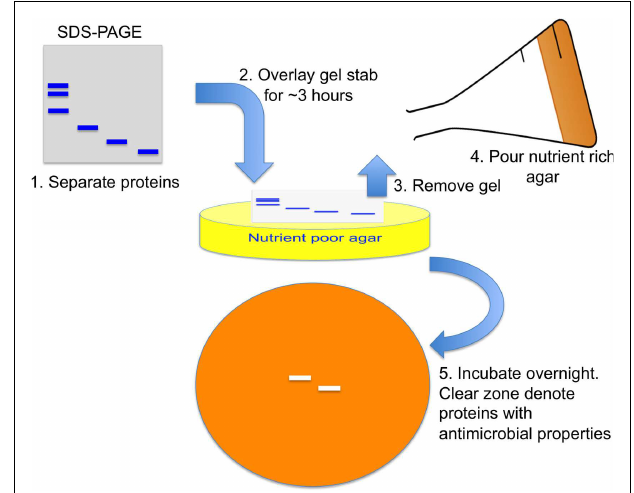
FIGURE 2 |Antimicrobial gel overlay assay. Proteins within a lysate with known antimicrobial properties are separated by SDS-PAGE. A nutrient poor agar with low sodium concentration is mixed with pathogen to make up the bottom layer. A piece of the SDS-PAGE gel stab is placed on top for several hours for proteins to diffuse from the gel onto the agar.The gel is then removed and a nutrient rich agar placed on top. After overnight incubation, a clear zone with no pathogen growth represents locations of antimicrobial